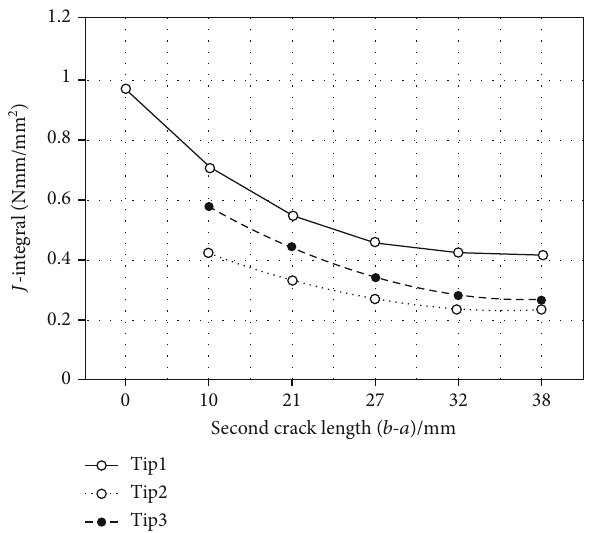
Figure 9: The J -integral variation with the second crack of double collinear insulation cracks.